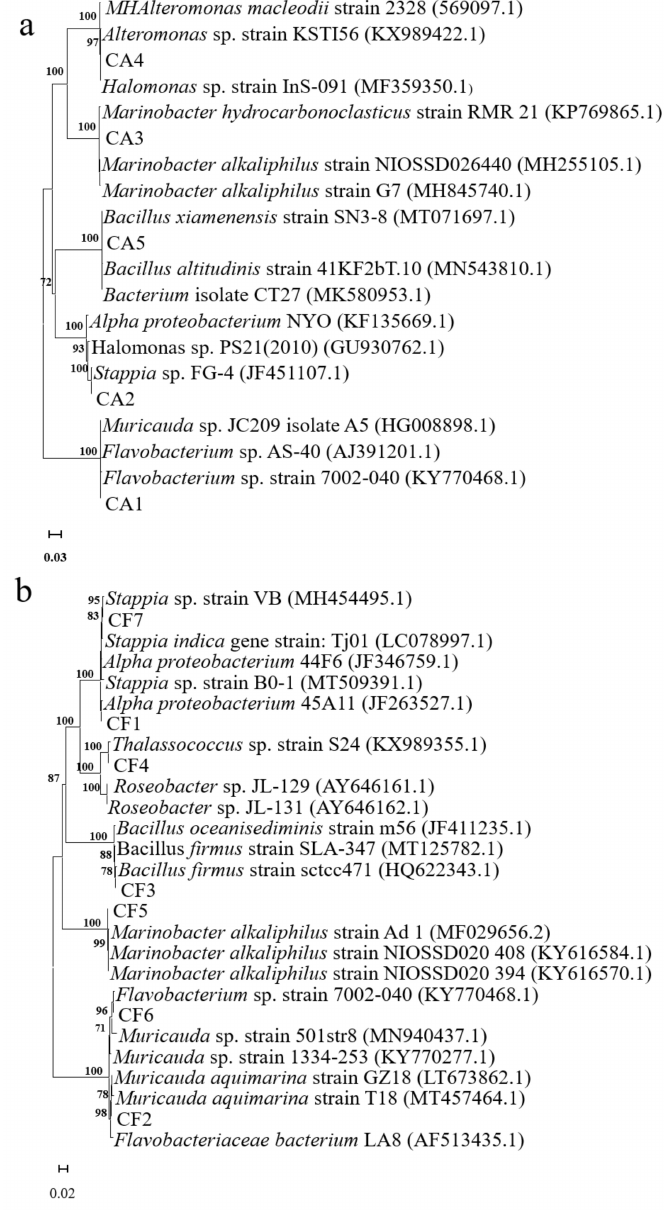
Figure 2. Phylogenetic evolutionary tree of the phycosphere bacteria isolated from C. dentata . ( a ) free-living bacteria; ( b ) attached